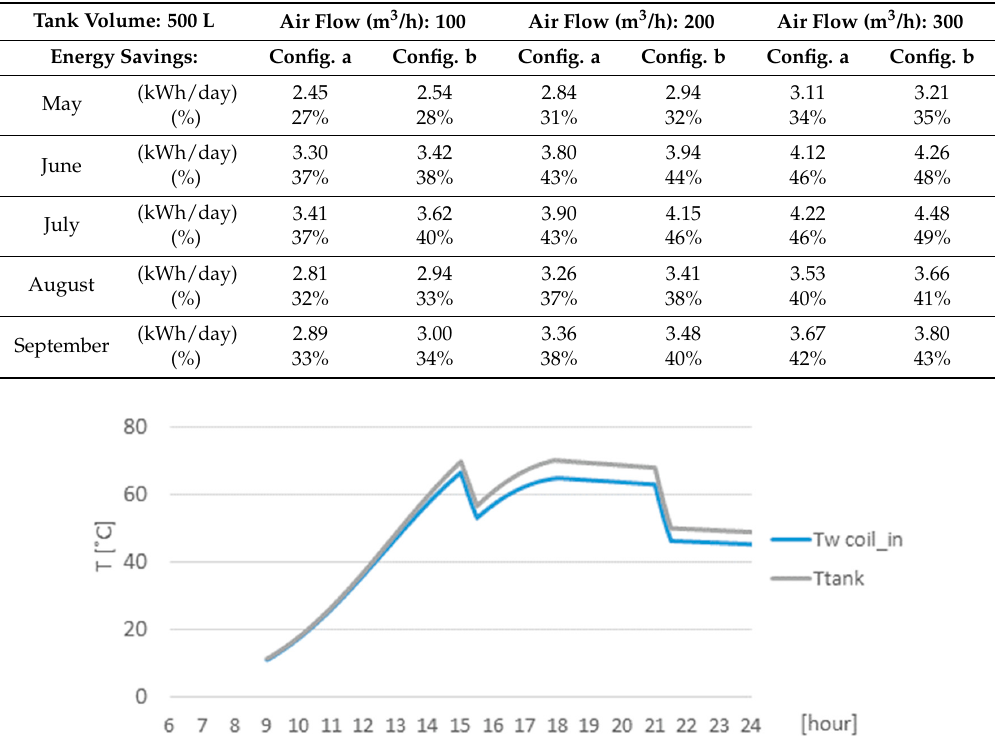
Figure 8. Water temperatures evolution in the tank and at the inlet of the heat exchanger, for configuration b.